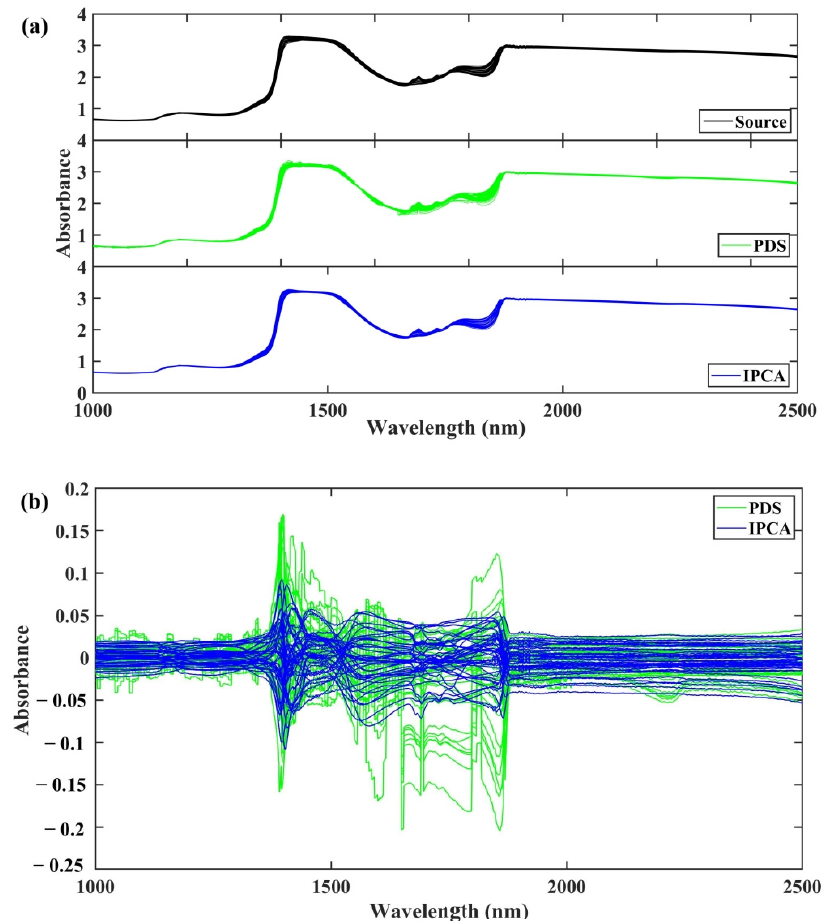
Figure 6. ( a ) Source (black) of transferred target spectra in dataset 3 with PDS (green) and IPCA (blue). ( b ) Different spectra obtained by subtracting original and transferred spectra in validation set with PDS (green) and IPCA (blue).